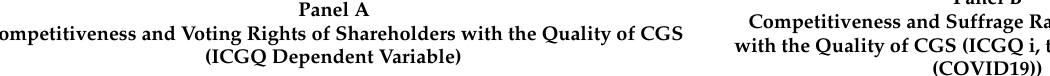
Panel B Competitiveness and Suffrage Ratio of Shareholders with the Quality of CGS (ICGQ i, t Dependent Variable